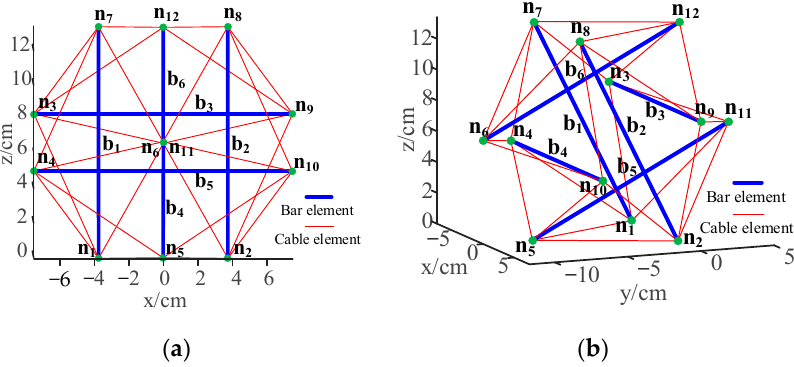
Figure 3. Structure topology of the six-bar tensegrity structure: ( a ) left view; ( b ) front view.